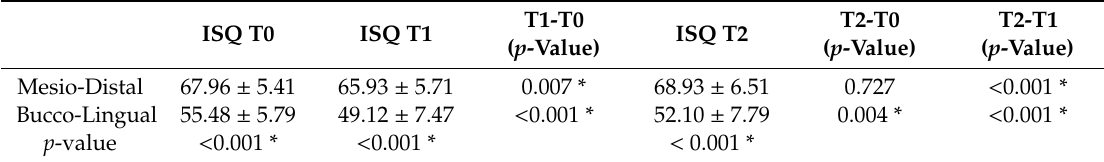
Table 2. Mean implant stability quotient (ISQ) measurements at the di ff erent time points.